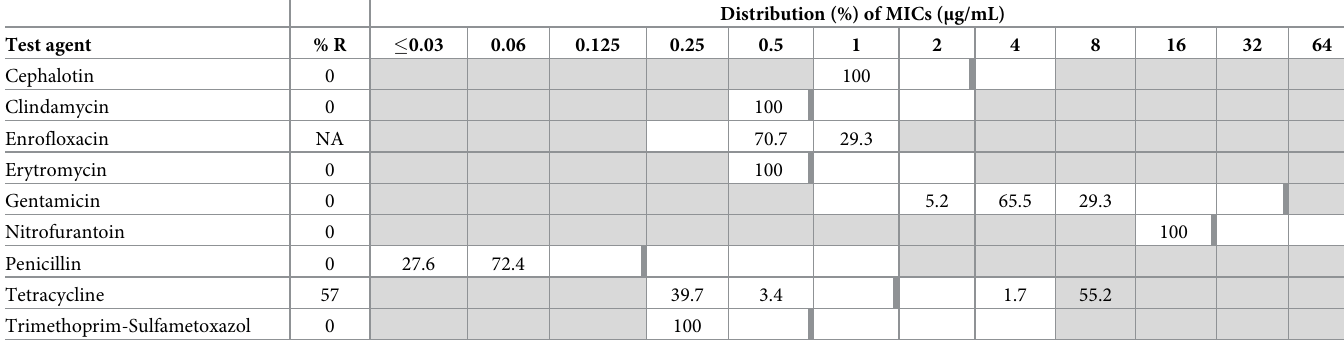
Table 5. Distribution (percentage of isolates) of minimum inhibitory concentration (MIC) and prevalence of non-WT or resistance (R, shown as percentage) for group B Streptococcus (n = 58) isolated from lactating camels and their calves in Laikipia County, Kenya, 2019 1 .